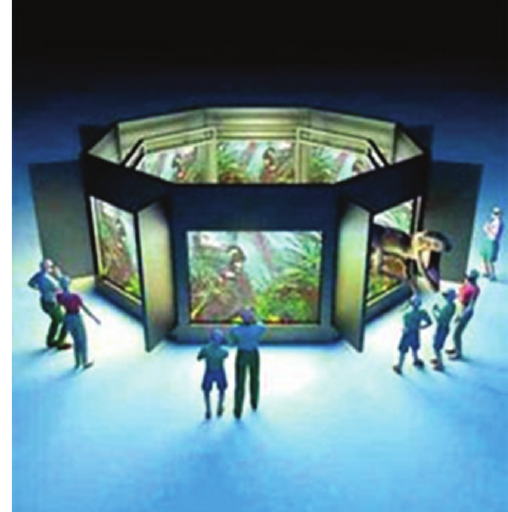
Figure 3: The virtual room [11].